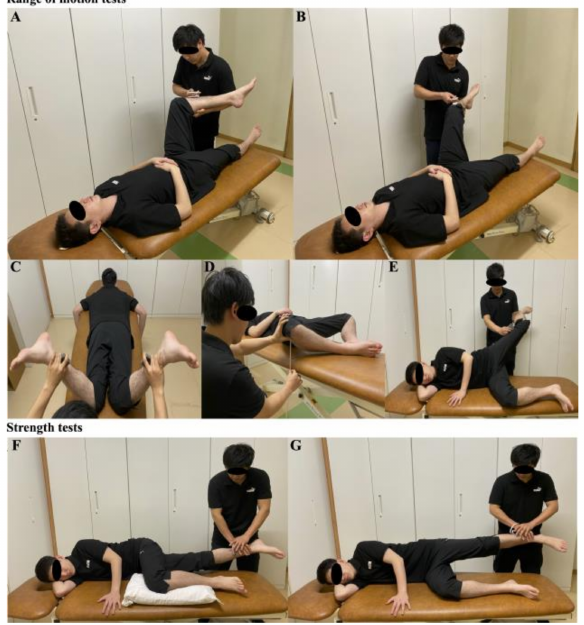
Figure 3. Musculoskeletal screening test battery analyzed in this study. ( A ) Internal rotation in the supine position. ( B ) External rotation. ( C ) Internal rotation in the prone position. ( D ) Bent-knee fall-out. ( E ) Abduction. ( F ) Eccentric adduction. ( G ) Eccentric